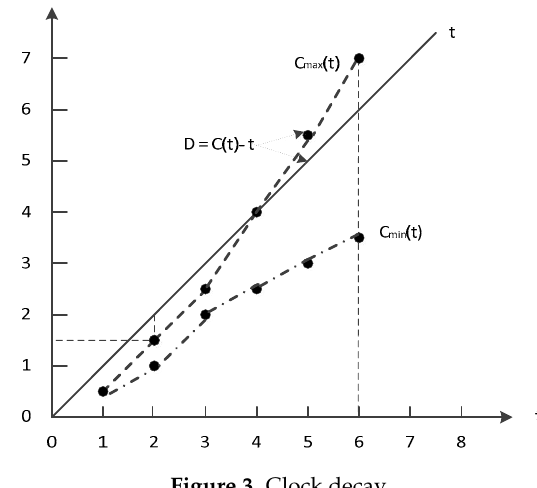
Figure 3. Clock decay. Figure 3. Clock